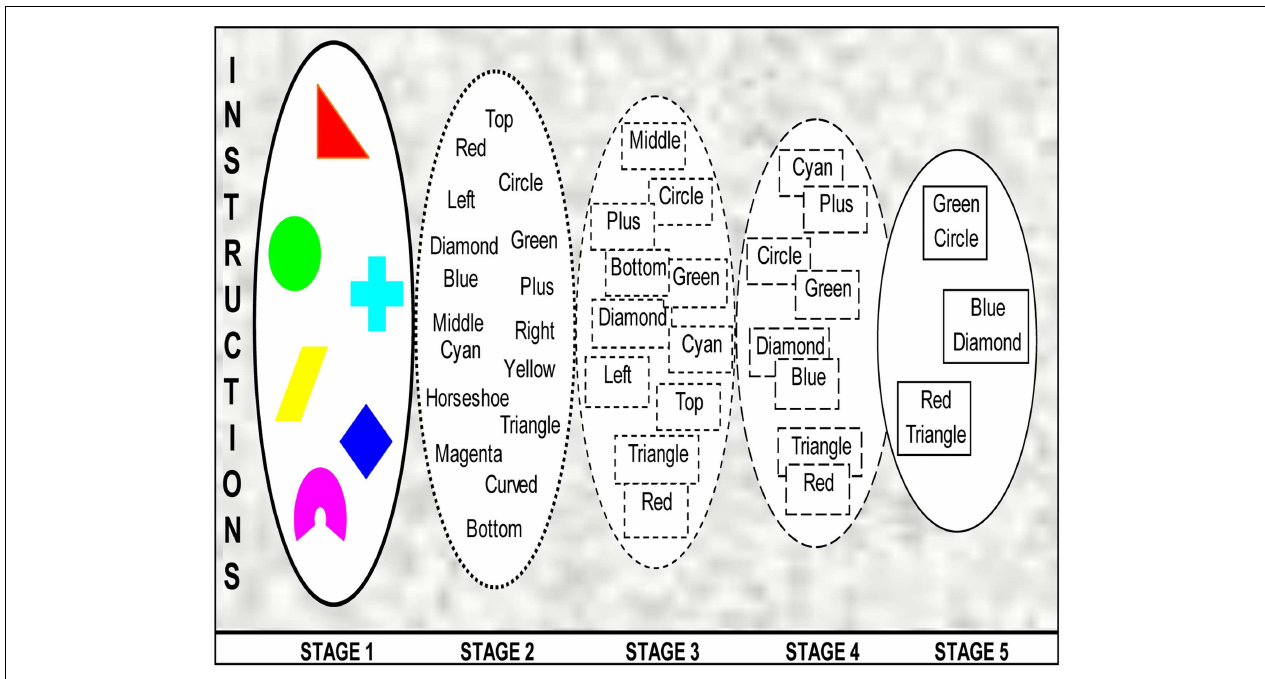
FIGURE 1 |The process of